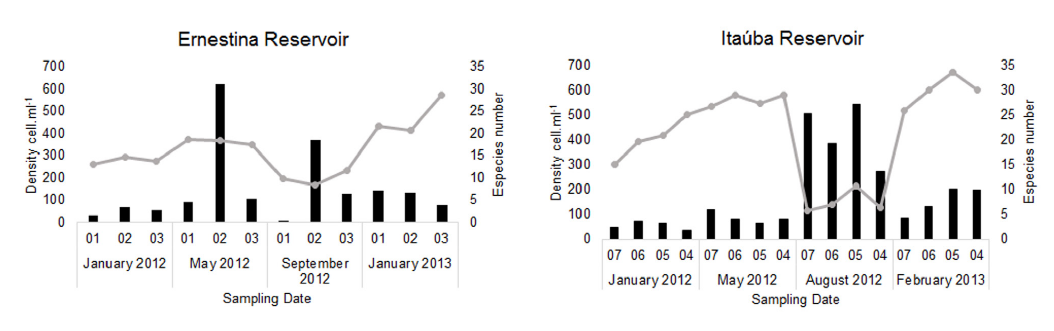
Figure 6. average cell density (bars) and number of species (dots) in each sampling unit in Ernestina (a) and Itaúba (b) reservoirs, between January 2012 and January